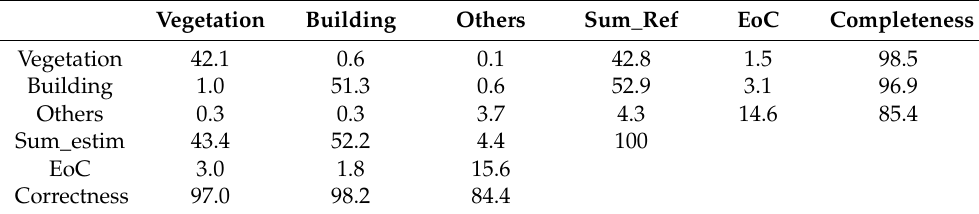
classification model.